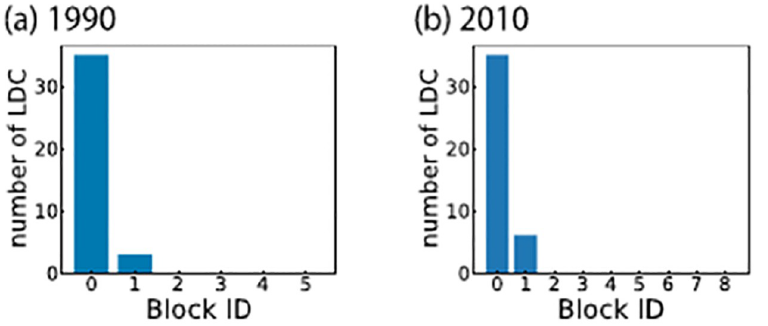
Fig 7. The number of LDCs in each stable block in (a) 1990 and (b) 2010. The stable blocks are in descending order of